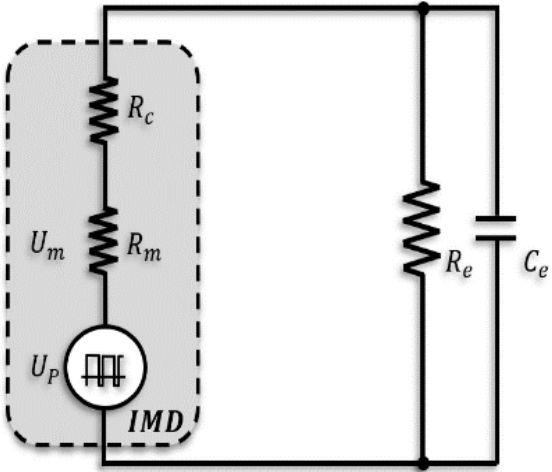
Figure 2. Equivalent circuit of isolation impedance and IMD.